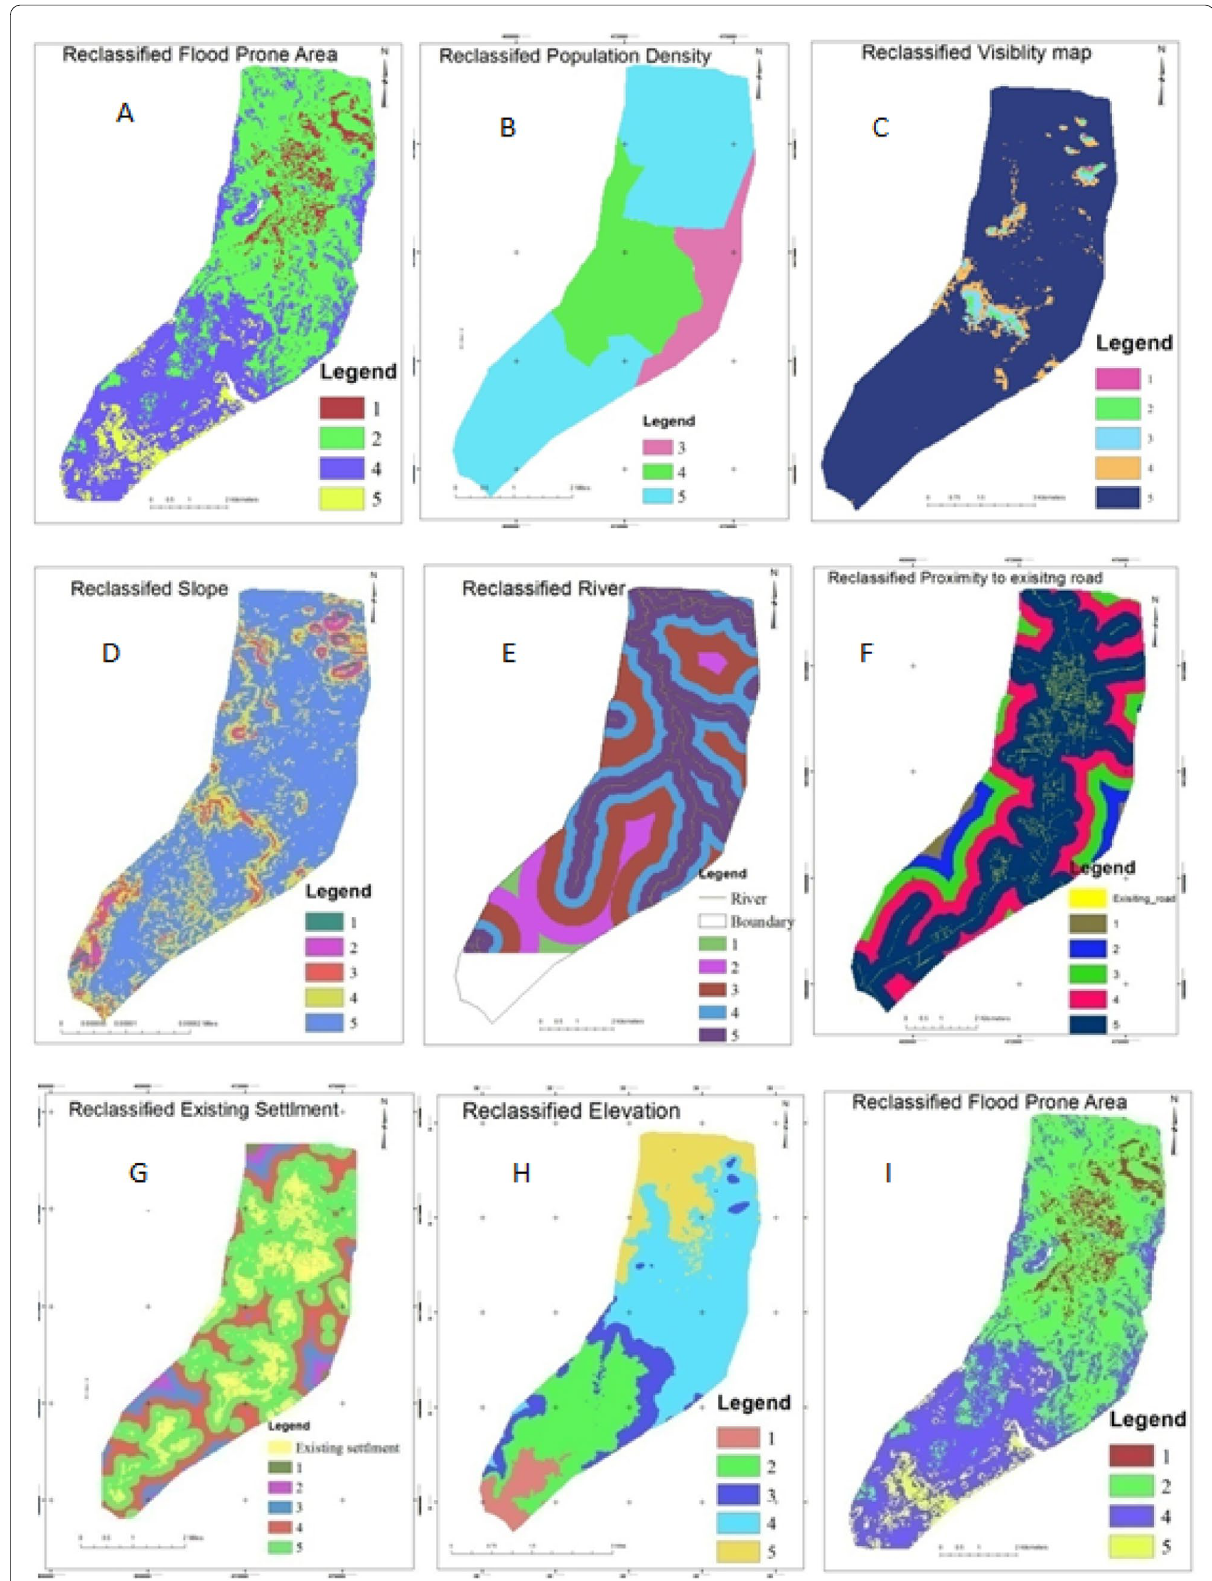
Fig. 2 Factor map to make suitability analysis for urban green